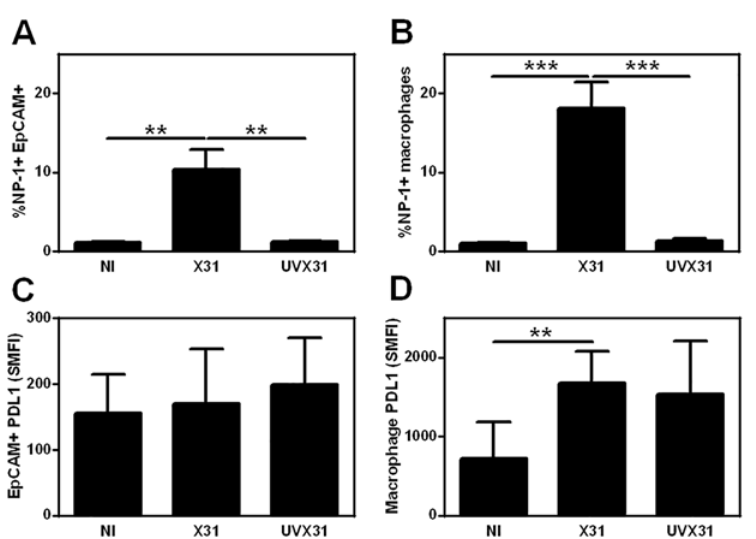
Fig 2. Quantification of infection of human lung explants. Histograms showing flow cytometry data of viral NP1 (% cells) and PDL1 expression (specific mean fluorescence intensity — SMFI) in epithelial cells (A & C) and macrophages (B & D). Data are expressed as means ± SE of 9 independent experiments. Data analysed using a paired t-test ** p < 0.01. **** p <